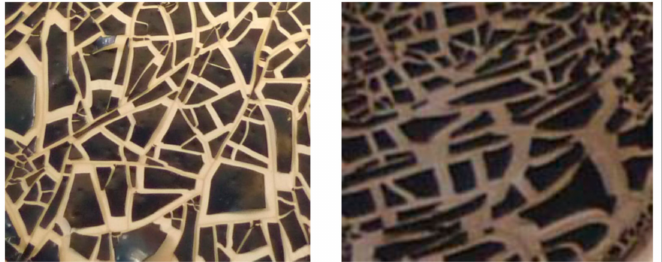
Figure 1. Laboratory sample of asphaltenes extracted from crude oil in n-heptane ( left ) and n-pentane ( right ).